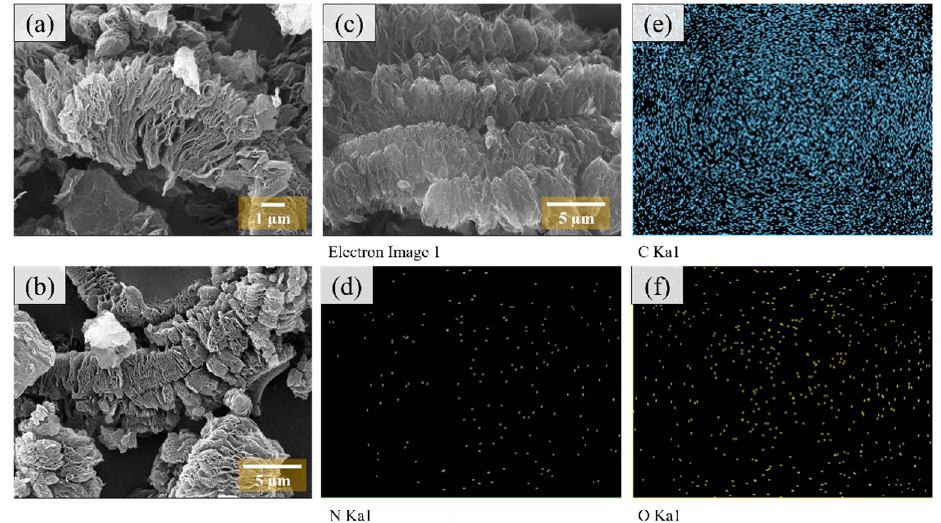
Figure 2. SEM images of ( a ) rGO and ( b ) NrGO, and ( c ) high-kinetic energy SEM image of NrGO equipped with element mapping, corresponding to ( d ) N, ( e ) C, and ( f ) O signals.